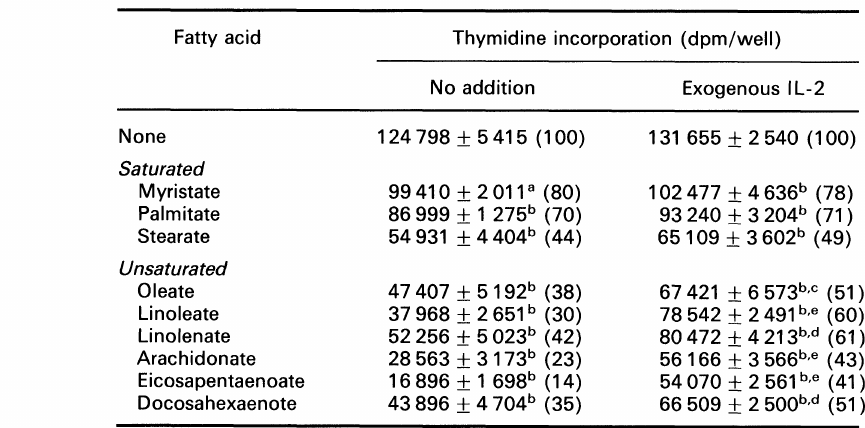
16896 _+ 698 b (14) 66 509 _+ 2 5005,d (51) Rat lymph node lymphocytes were cultured in the presence of Con A and 100 #M fatty acid-albumin complexes. In some cases the medium was also supplemented with recombinant human IL-2 (20 units/ml). Proliferation was assessed by the incorporation of radioactive thymidine into DNA over the final 18 h of a 66 h culture period. Data are the mean _+ SEM of six determinations. Statistical significance vs. control cells (i.e. no fatty acid addition) ap < 0.01, bp < 0.001 VS. no IL-2 addition" Cp < 0.05, dp< 0.01, ep < 0.001. Numbers in parentheses are thymidine incorporation as a percentage of the control mean.